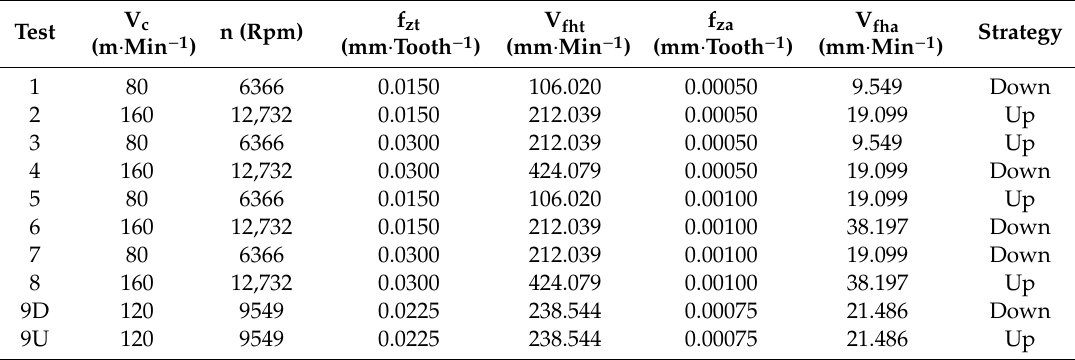
Table 9. Summary of machining parameters.